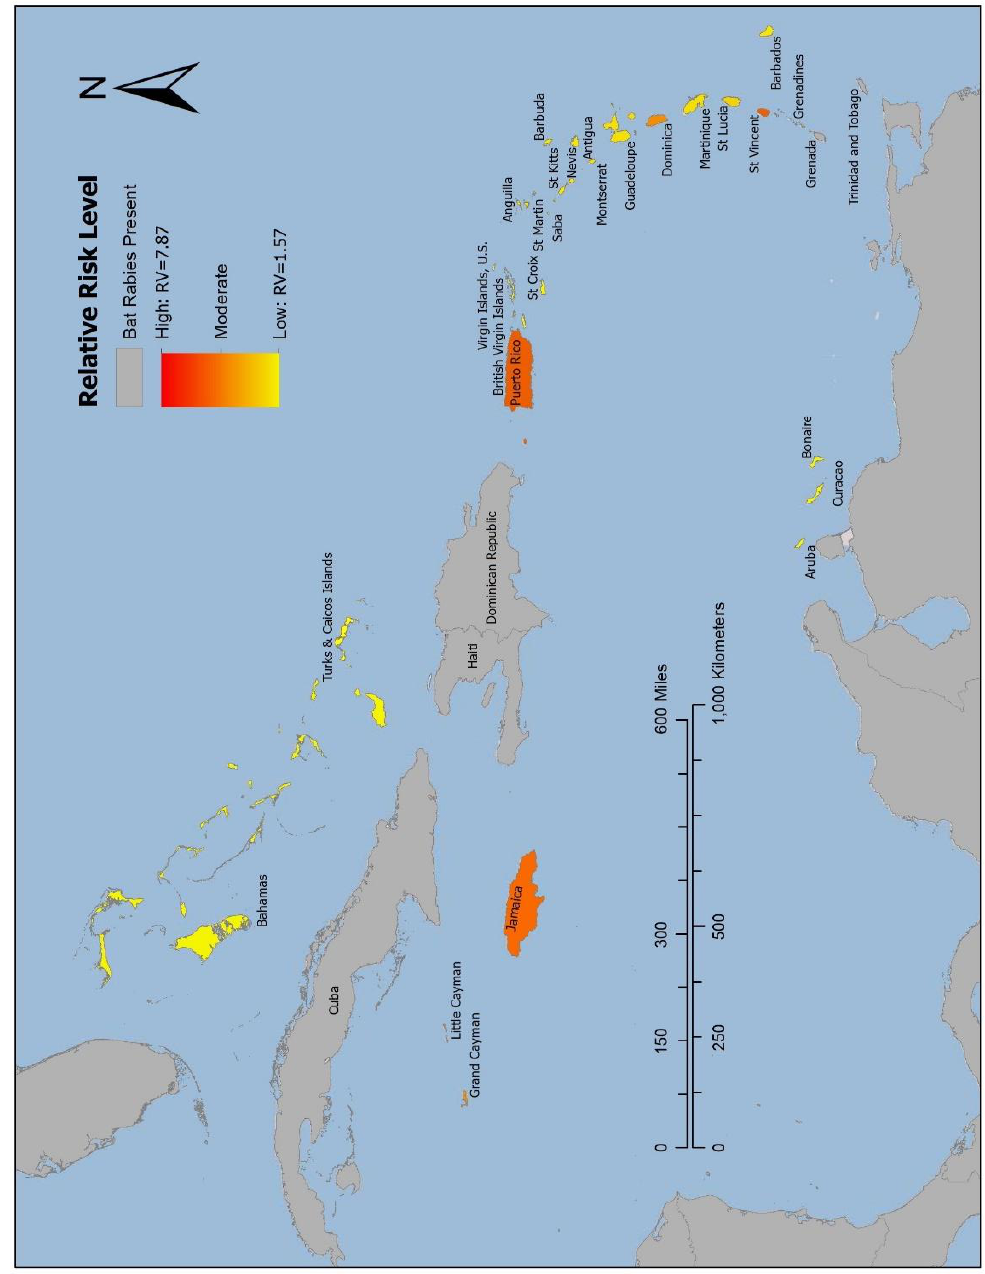
Figure 4. Risk map of bat rabies presence in the Caribbean islands. Choropleth map displaying relative risk level of bat rabies-free Caribbean island countries for presence of rabies virus in bat populations. Countries where bat rabies has been documented are shown in gray, high risk is symbolized by shades of red and orange, and lower risk is symbolized by shades of yellow.